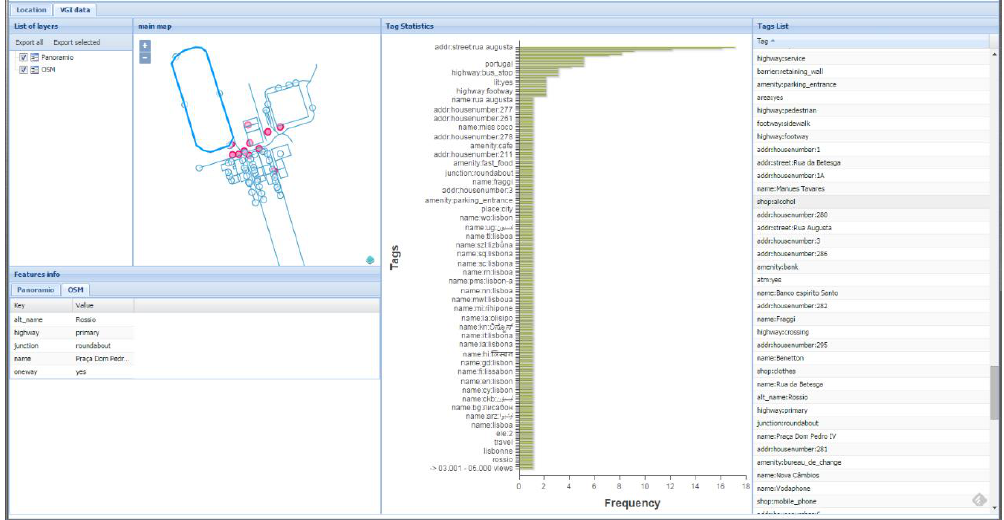
Figure 6. Features dashboard for the cartography validation use case (note: the light blue features depict OpenStreetMap (OSM) features, the red features represent Panoramio photos, and the highlighted blue features represent the OSM selected feature).